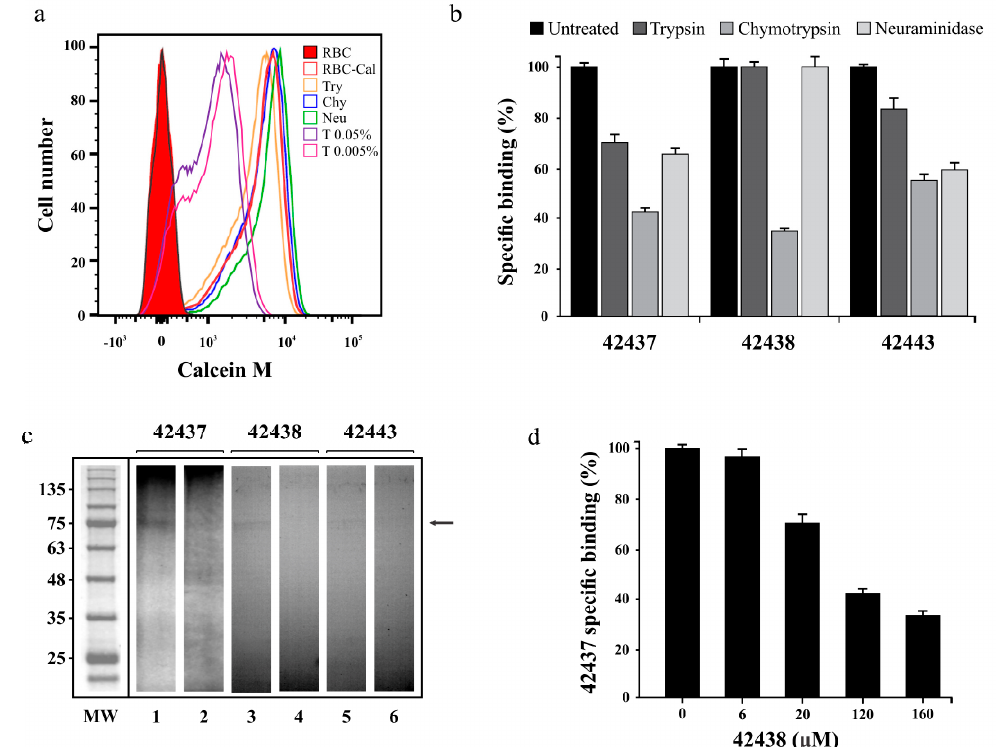
Figure 2. Peptides’ specific binding activity. ( a ) Cell viability assay showing Calcein M signal ( x -axis) and the amount of cells ( y -axis). Bovine RBC treated with trypsin (Try) chymotrypsin (Chy), neuraminidase (Neu), Triton X-100 (T) or dyed with Calcein M (RBC-Cal) are also shown. ( b ) Specific binding effect of enzyme treatment on B. bovis AMA-1 42437, 42438 and 42443 peptides. The specific enzyme-treated erythrocyte binding percentage is represented by a bar. Untreated RBC were used as control. ( c ) Cross-linking assay. The autoradiogram shows radiolabelled HABPs’ total (odd lane) and inhibited (even lane) binding to erythrocytes using non-radiolabelled peptides. The molecular weight (MW) pattern and receptor (arrow) found are also shown. ( d ) Peptide 43437 binding competition assay, using different non-radiolabelled peptide 42443 concentrations. The 42443 binding percentage and µ M concentration are shown. Standard deviations for Figure 2b,d were below